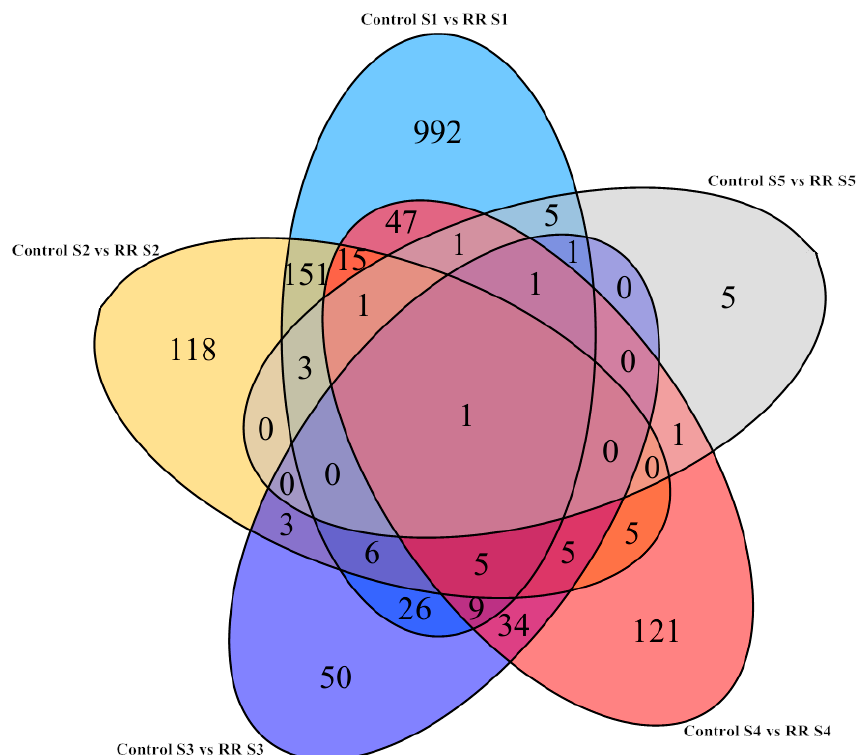
Figure 2. Venn diagrams showing the number of overlapping and non-overlapping genes with significantly differential expression levels (FDR < 0.05 and Log 2 FC > 1) during developmental stages under root restriction treatment. Ligte blue, the number of genes at the fruitlet stage; Yellow, the number of genes at the immature green stage; Dark blue, the number of genes at the before veraison stage; Red, the number of genes at the veraison stage; Gray, the number of genes at the fully ripe stage. FDR, false discovery rate; FC, fold change.